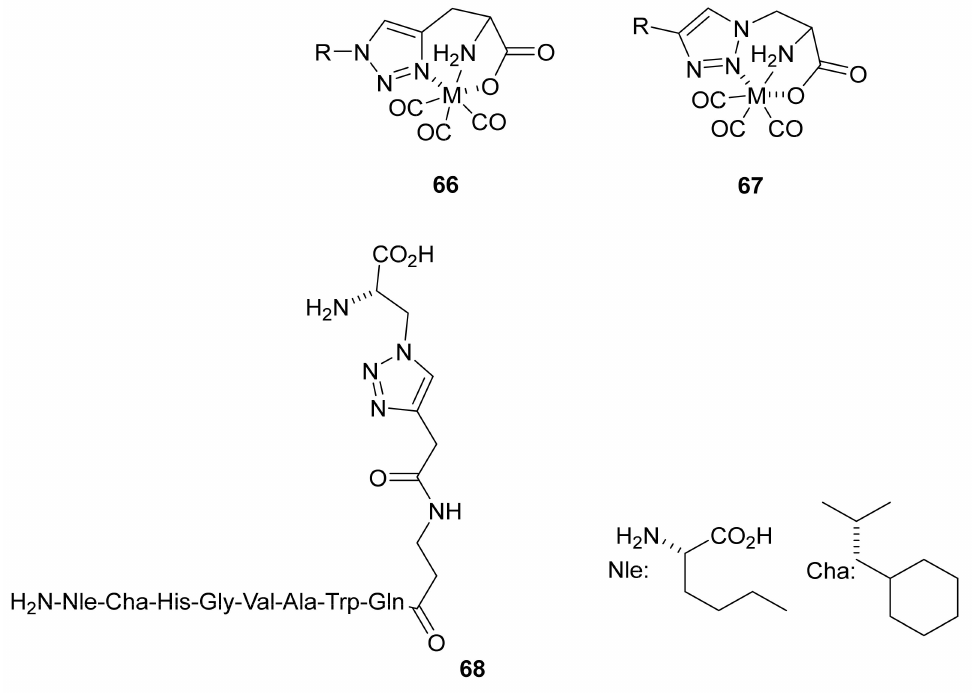
Figure 24. Metal complexes 66 and 67 obtained from the triazole peptide derivative 68 .